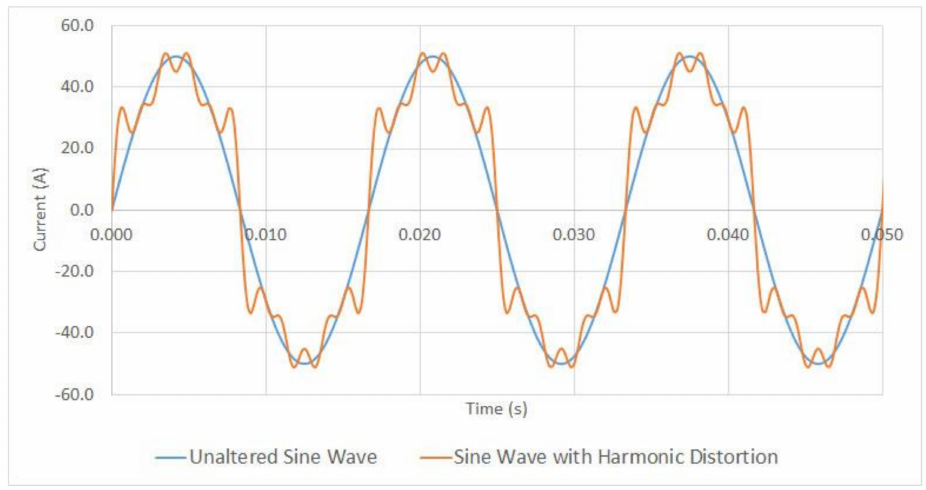
Figure 1. Voltage wave quality showing the effects of harmonic distortion